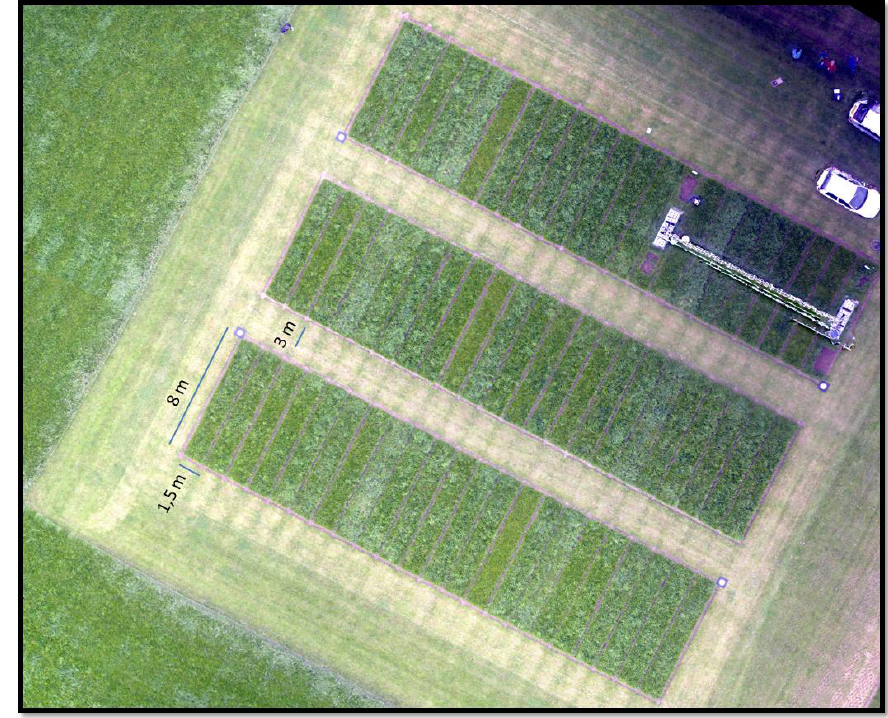
Figure 1. RGB ortho-mosaic of the experimental grassland plots on 15 May 2014, acquired using the Panasonic GX1 camera of the Wageningen UR Hyperspectral Mapping System